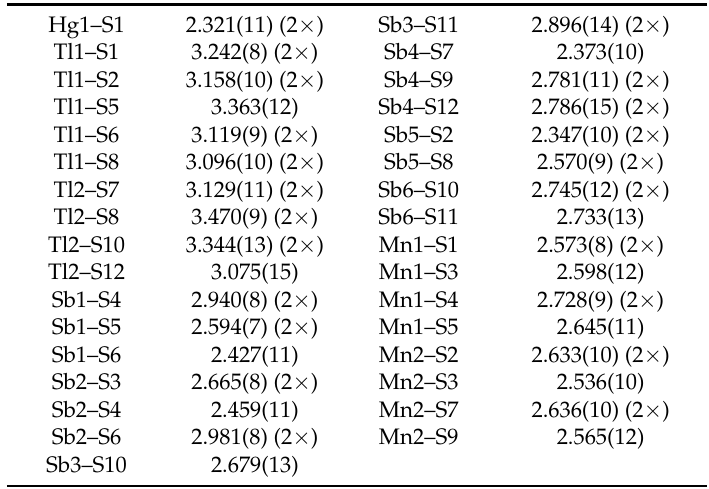
Table 6. Selected interatomic distances (Å) in